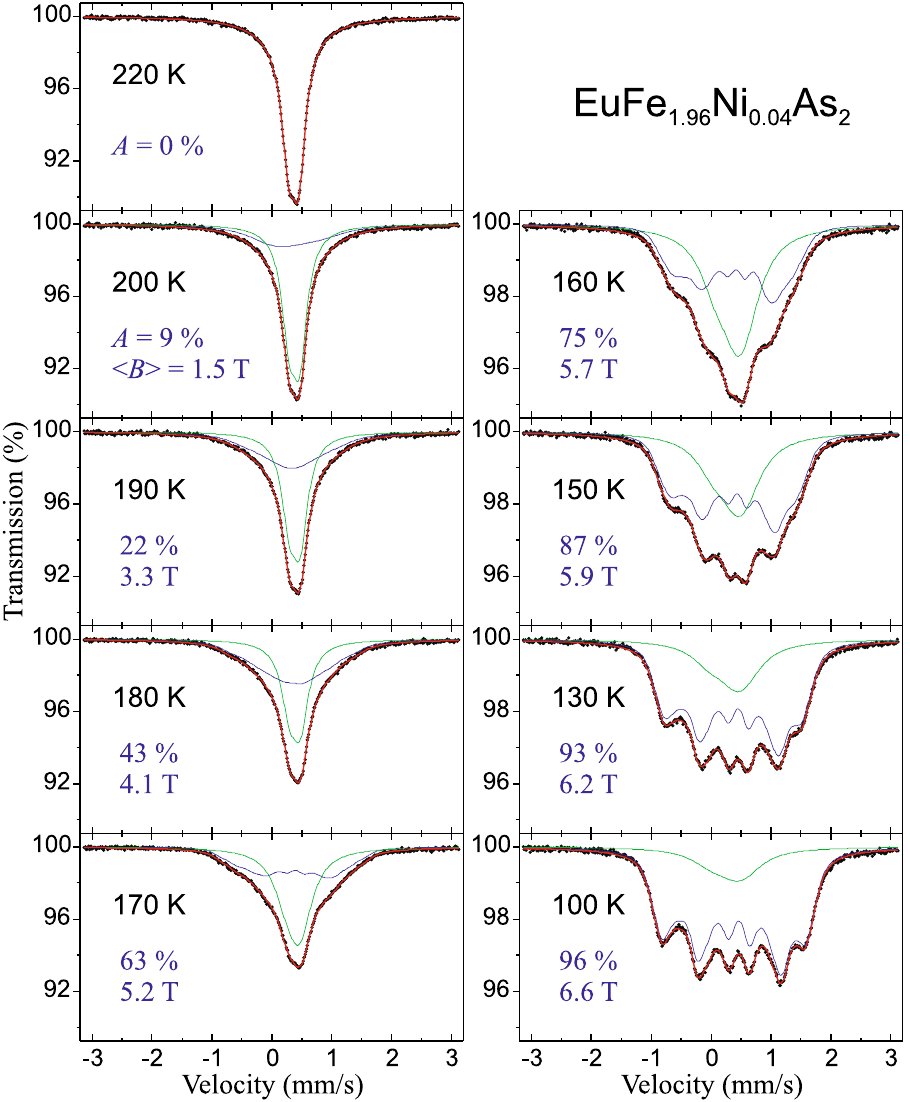
Figure 4. Selected 57 Fe Mössbauer spectra of EuFe 1.96 Ni 0.04 As 2 versus temperature across the SDW order. (Inserted values) The contribution of the SDW spectral component A , and the average magnetic hyperfine field of SDW < B > . Spectra were measured at the same conditions during non-interrupted series and they are shown for comparison on the same scale, except that the left column scale is twice the scale of the right one. The influence of the magnetic SDW order on the shape of the spectra is clearly